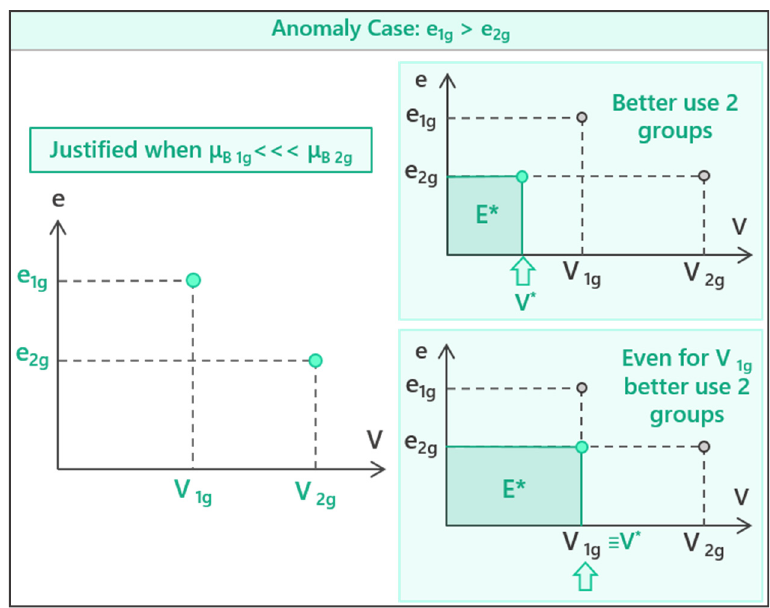
Figure 7. Anomaly case, when solutions A and B do not apply.